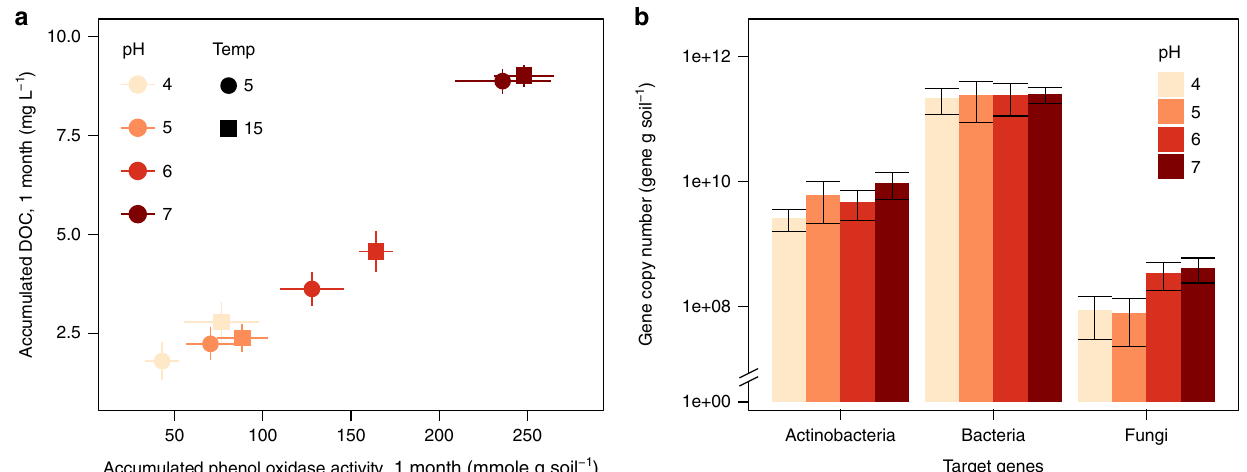
Fig. 4 pH effects on phenol oxidase and gene copy numbers in the lab incubation. Relationship between accumulated DOC and phenol oxidase activities at different pH and temperatures ( a ) and the abundances of microorganisms ( b ) in peat soils incubated over a month-period